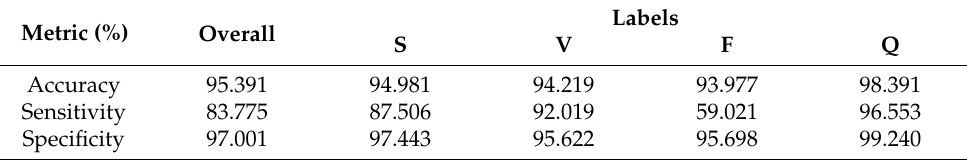
Figure 14. Normalized confusion matrix for Model B on test dataset. Table 6. Performance metrics for Model B on test dataset.